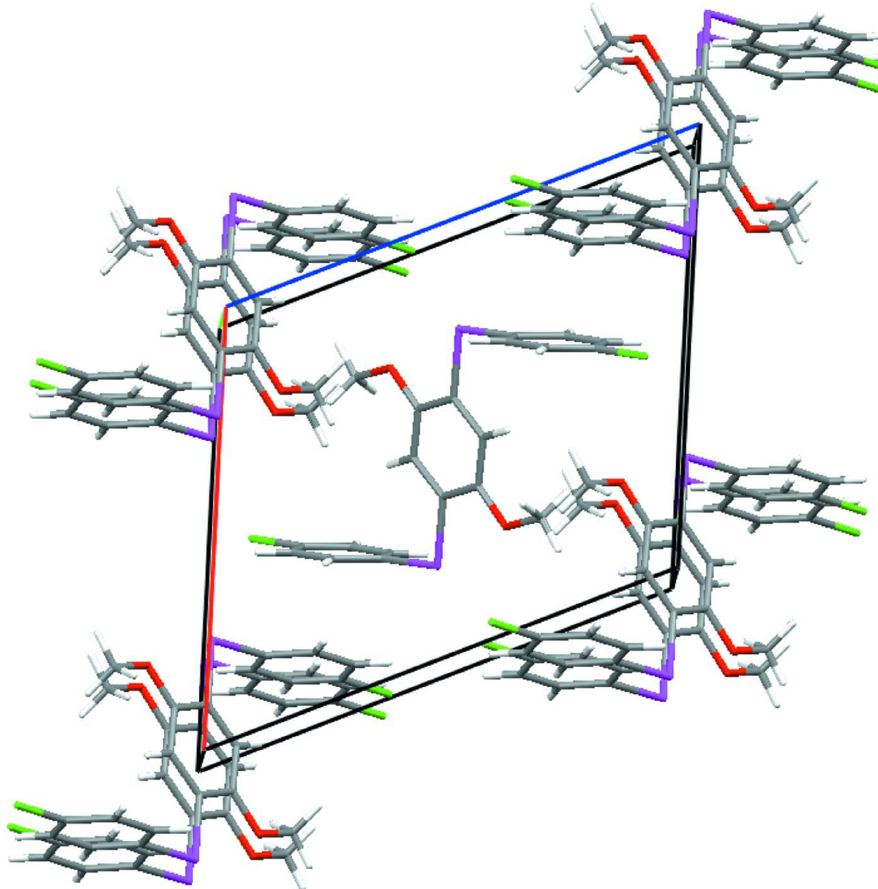
Figure 3 Packing diagram of viewed down the b